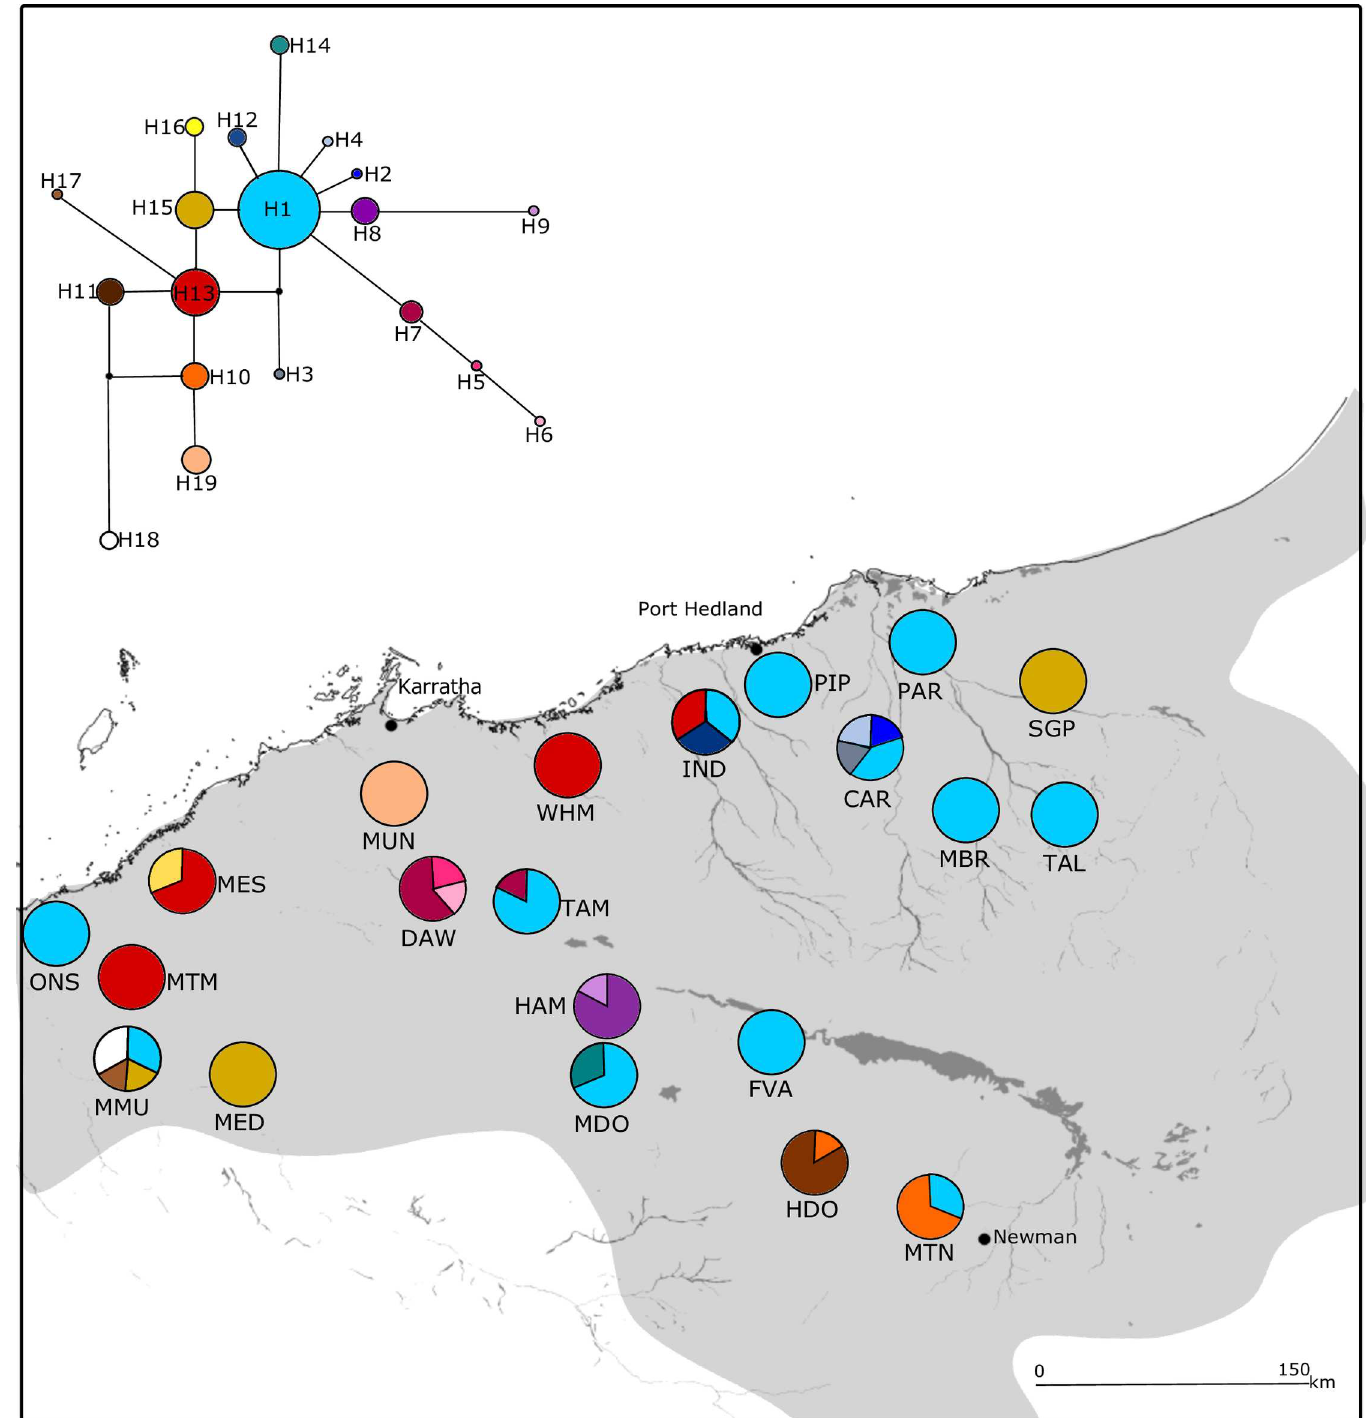
Fig 3. Geographical distribution of populations and chloroplast haplotypes for Acacia atkinsiana . The species distributionis shown in grey. All chloroplast haplotypesfound in each populationare shown with section sizes indicatingthe proportion of individualswith that haplotype. The haplotype network is shown in the upper left corner, each circle represents a distinct haplotypeand its size indicates its relative frequency amongst all individuals. Branch length indicatesthe number of mutational steps between haplotypesand unobservedhaplotypes are represented by black circles. Major water courses and the Fortescue floodplainare